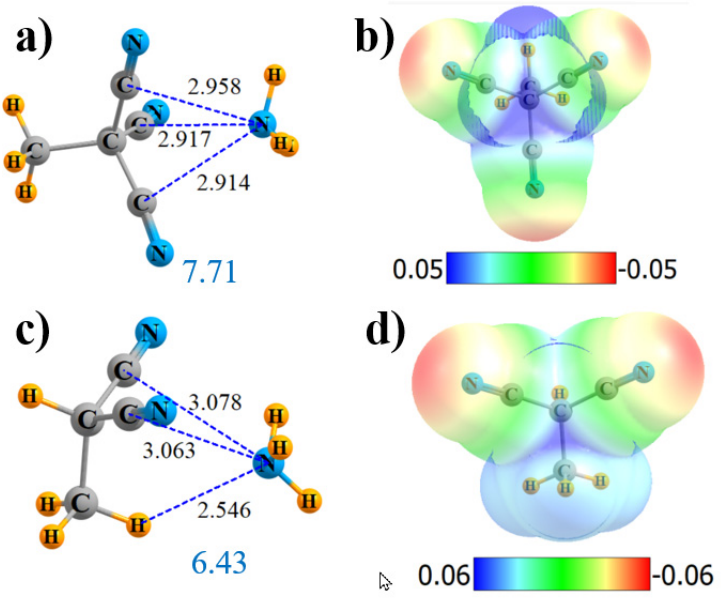
Figure3. GeometriesandmonomerMEPofcomplexofNH 3 withH 3 C-C(CN) 3 ( a , b )andH 3 C-CH(CN) 2 ( c , d Figure 3. Geometries and monomer MEP of complex of NH 3 with H 3 C-C(CN) 3 ( a , b ) and H 3 C-CH(CN) 2 ( c , d ).